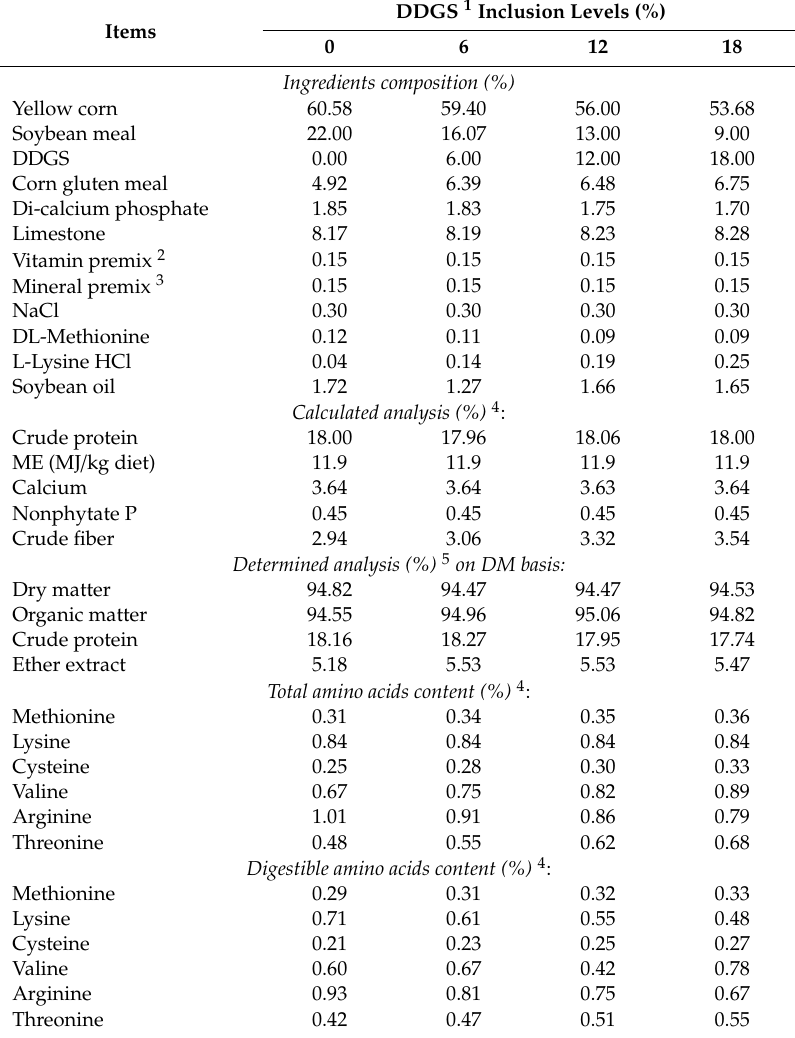
Table 1. Composition and chemical analysis of each